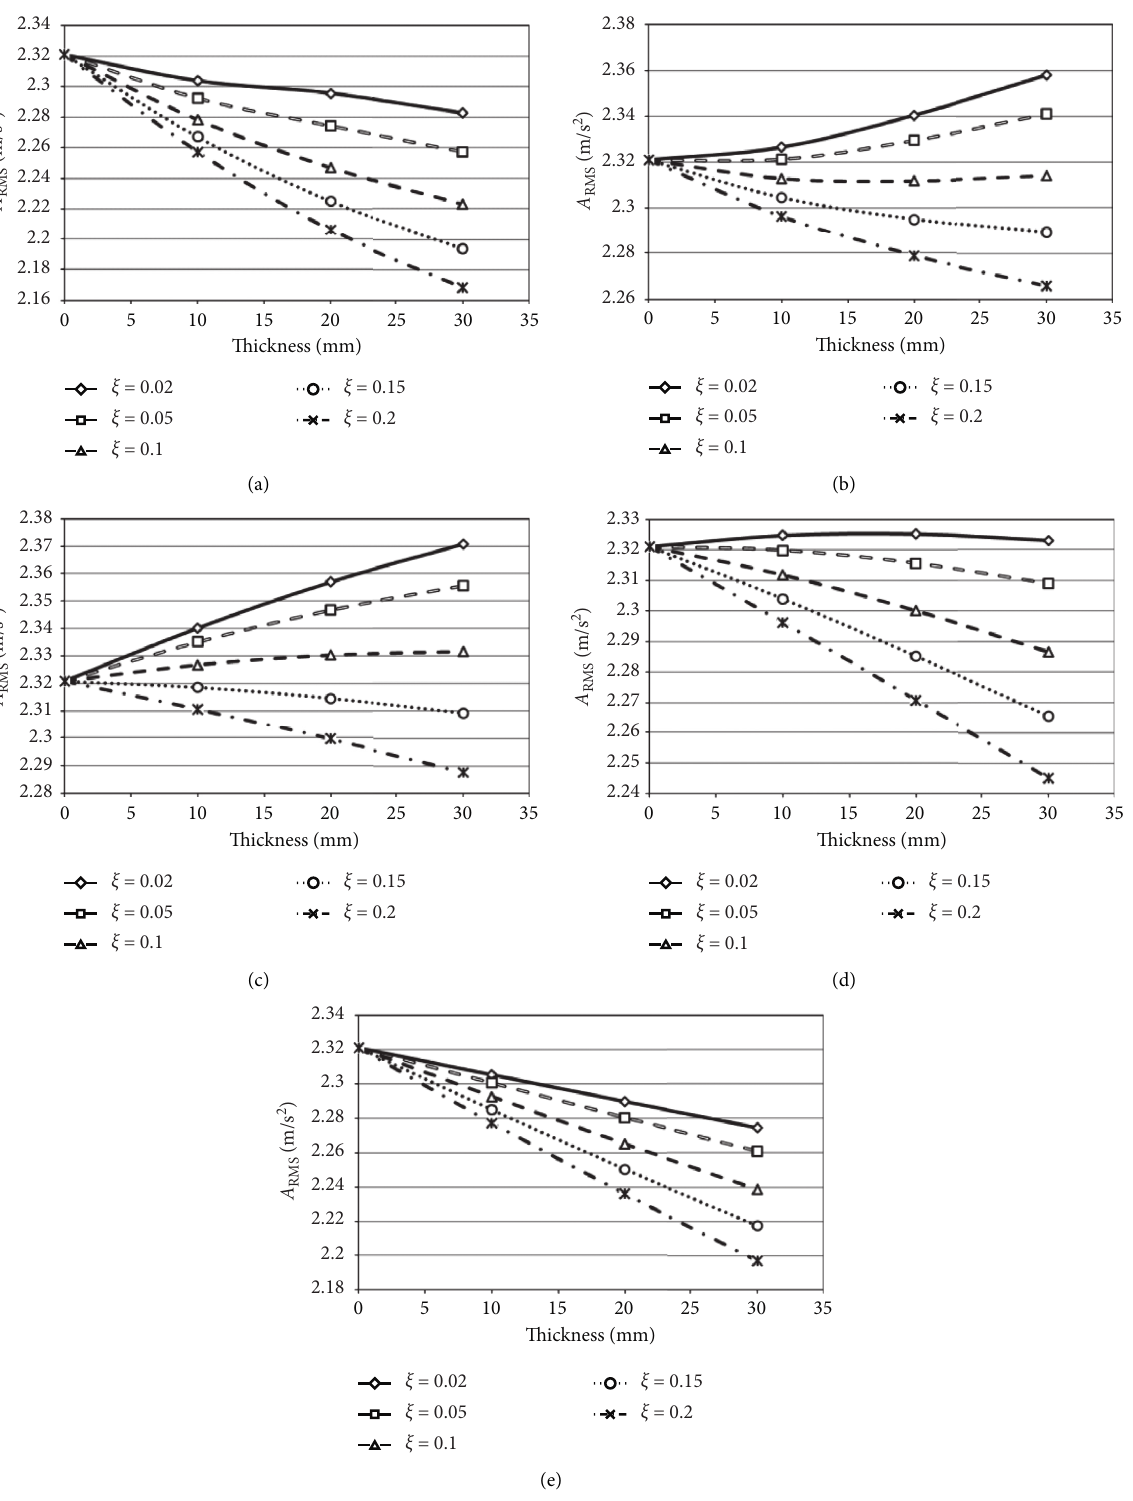
Figure 10: The effects of damping thickness at monitored point A. (a) 0cm from the top. (b) 5cm from the top. (c) 10cm from the top. (d) 15cm from the top. (e) 20cm from the